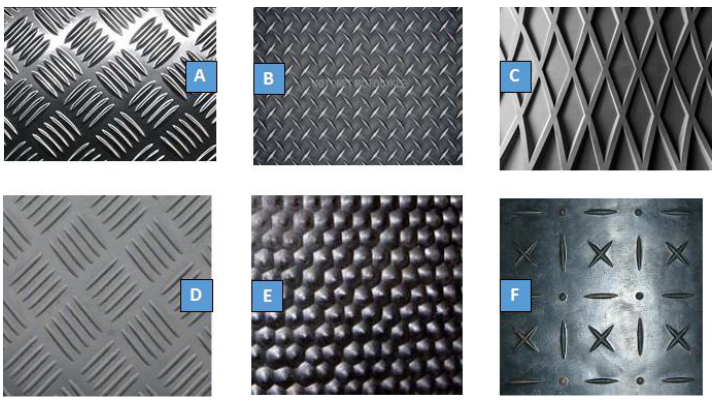
Figure 5. Tread plate metal patterns: ( A ) — Quintuple tear; ( B ) — Single tear; ( C ) — Grid; ( D ) — Quintuple tear; ( E ) — Protrusions; ( F ) — Mixed pattern (sometimes referred to as “ knurled pattern ” ).